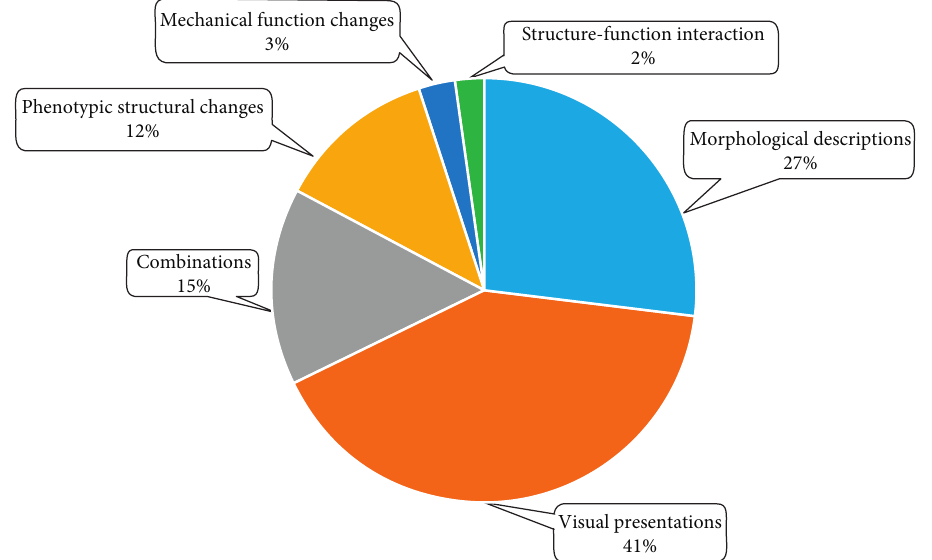
Figure 7: Plant visualization model classification.